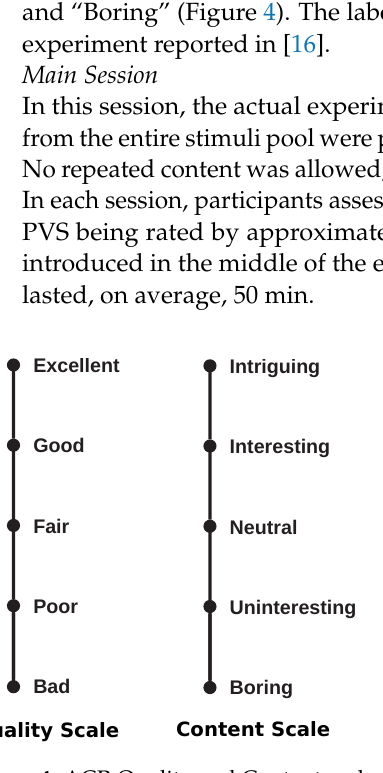
Figure 4. ACR Quality and Content